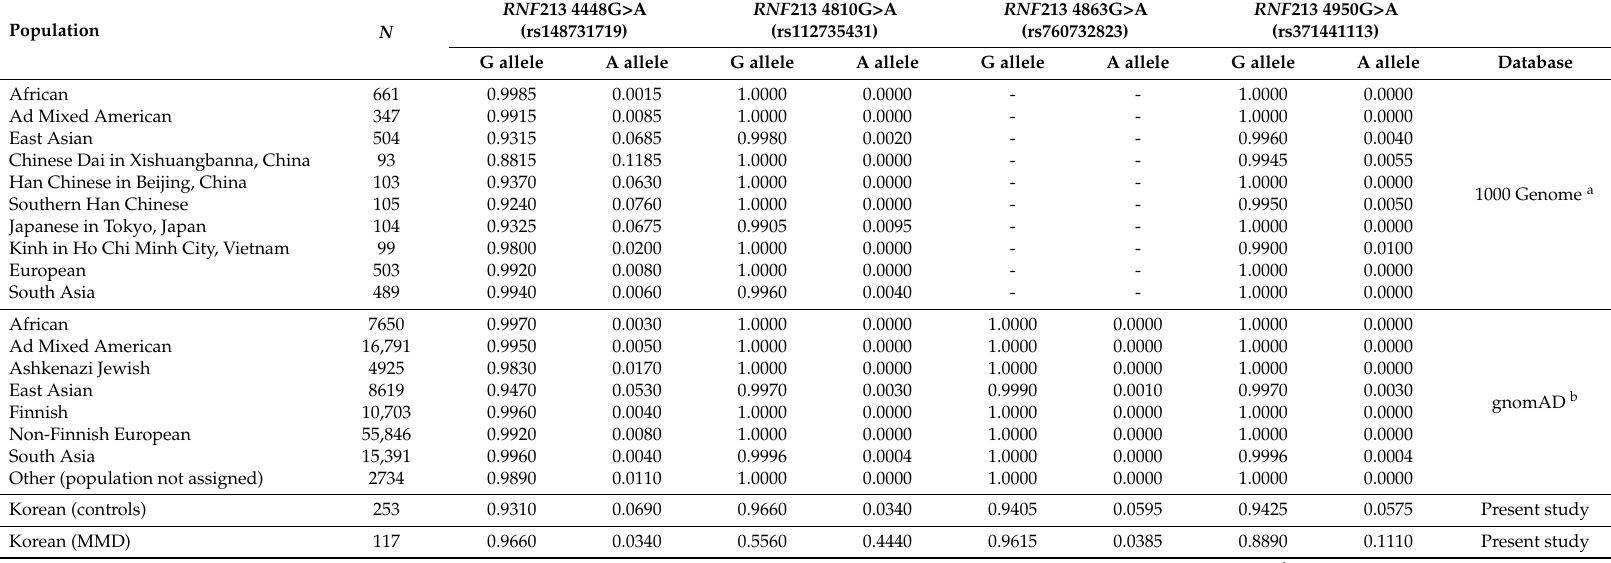
Table 8. Allele frequencies of RNF 213 polymorphisms (4448G>A, 4810G>A, 4863G>A, and 4950G>A) in different world